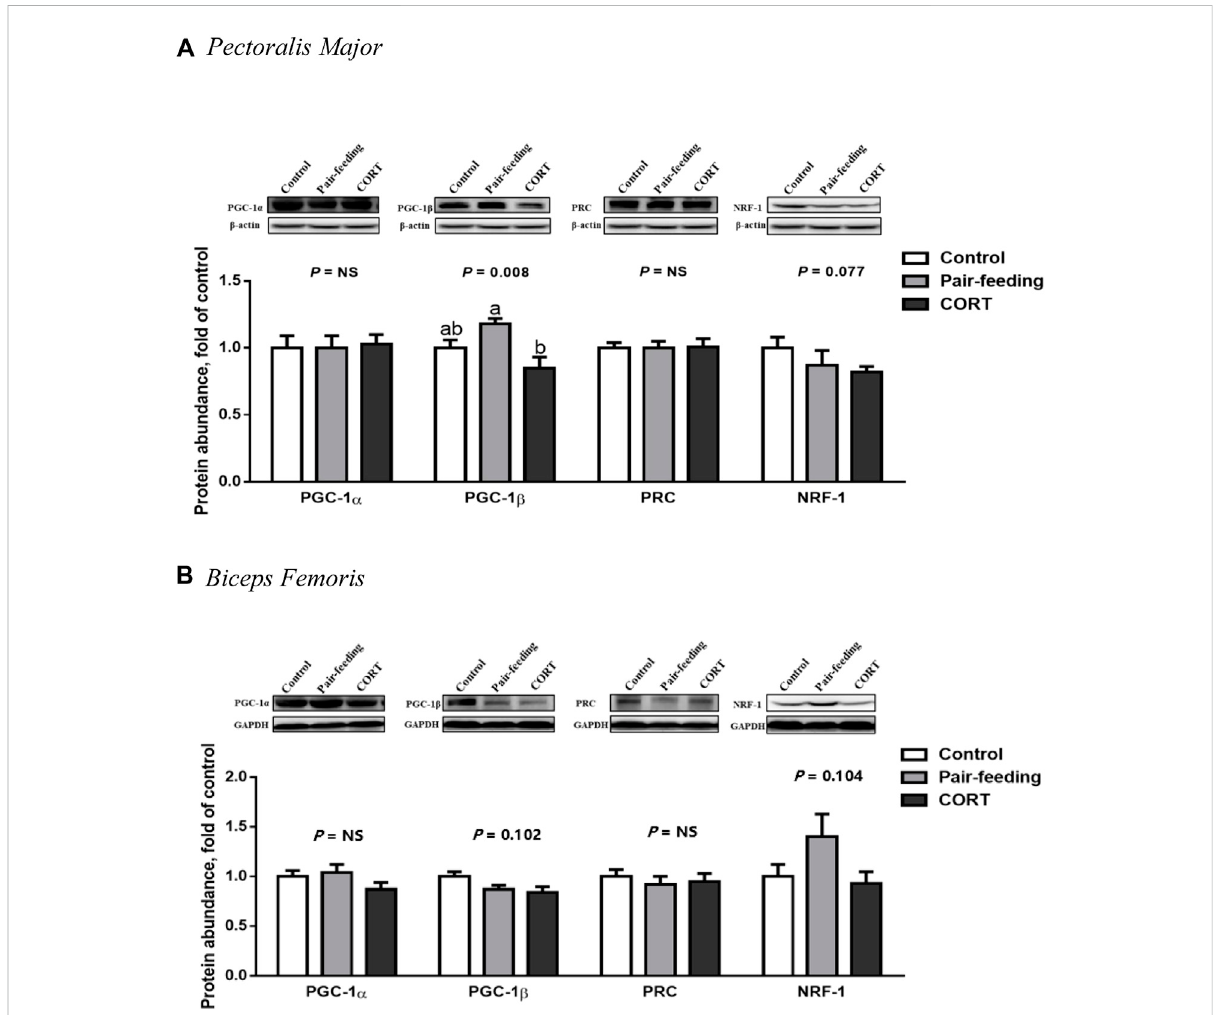
FIGURE 5 Protein abundance of PGC-1 familymembers and NRF-1 in pectoralismajor (A) and biceps femoris (B) muscles of broiler chickens treated with corticosterone (CORT, 30 mg/kg diet from 30 to 37 d of age). Data are means of 12 individuals of 2 birds per replicate. a,b Means without a common superscript differ ( p < 0.05). PGC-1, peroxisome proliferator-activated receptor γ coactivator 1; PRC, PGC-1 related coactivator; NRF-1, nuclear respiratory factor 1; GAPDH, glyceraldehyde-3-phosphate dehydrogenase; NS, p >